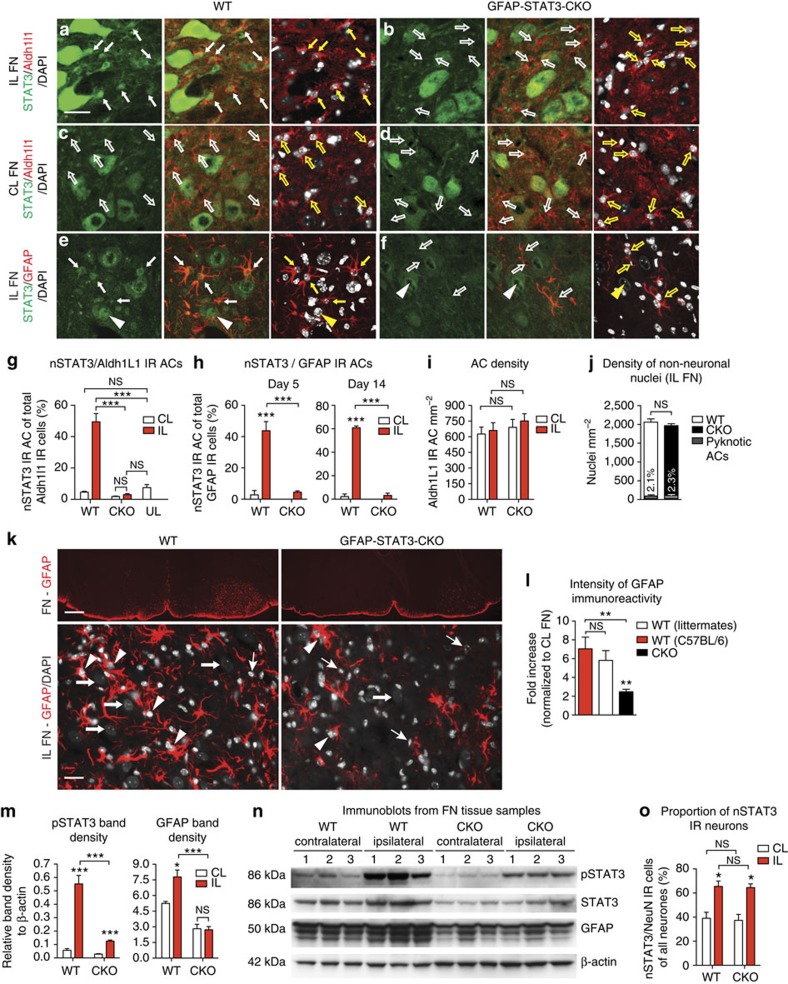
STAT3 activation is necessary for reactive transformation of perineuronal ACs after remote injury.(a–f,k) Grey matter AC response in the facial nucleus (FN) 14 days post-facial nerve transection. (a–d) Nuclear localization of STAT3 in Aldh1L1 IR ACs (fluorescent microscopy), (e,f) in GFAP IR reactive ACs (thin arrows; confocal images) and in motor neurons (arrowheads) in the IL FN of WT mice (a,e) and its relative absence (empty arrows) in the CL side in WT mice (c) and in CKO mice (b,d,f). (g) Proportion of Aldh1L1 IR ACs and (h) GFAP IR ACs displaying nSTAT3 labelling at day 5 or 14 post axotomy in WT mice (n=3) and in CKO mice (n=5) (g, ***P<0.001, one-way analysis of variance (ANOVA); h, n=3, ***P<0.001, one-way ANOVA P<0.0001). (i) AC density is expressed as mean of Aldh1L1 IR cell count (mm−2), which is comparable in WT and CKO groups and remains unchanged after axotomy (n=4, NSP=0.645, one-way ANOVA). (j) Numbers of intact non-neuronal nuclei (n=3, NSP=0.39, t-test ) and the proportion of pyknotic ACs in both groups (n=3, NSP=0.634, t-test ). (k) GFAP immunoreactivity in the axotomized and CL FN in WT mice and in CKO mice. GFAP IR ACs (arrowheads) surround axotomized neurons (full arrows) and display marginal pyknosis (thin arrows) in the two groups. (l) Mean intensity (optical density) values for IL GFAP immunoreactivity normalized to the CL side within the same section (WT n=3, CKO n=6, NSP=0.49, t-test; **P<0.01, one-way ANOVA P=0.0013). (m) Means of band densities for pSTAT3 and GFAP immunoblots (n, Supplementary Fig. 1) of IL and CL FN tissue samples, demonstrating overall STAT3 phosphorylation induced by axotomy in WT mice and to a lesser extent in CKO mice (n=3, ***P<0.001, *P<0.05, one-way ANOVA). (o) Mean percentages of neurons displaying nSTAT3 labeling. Scale bar, 30 μm for a–f; 250 μm and 20 μm for k; n=mice per group. Data represent mean±s.e.m.